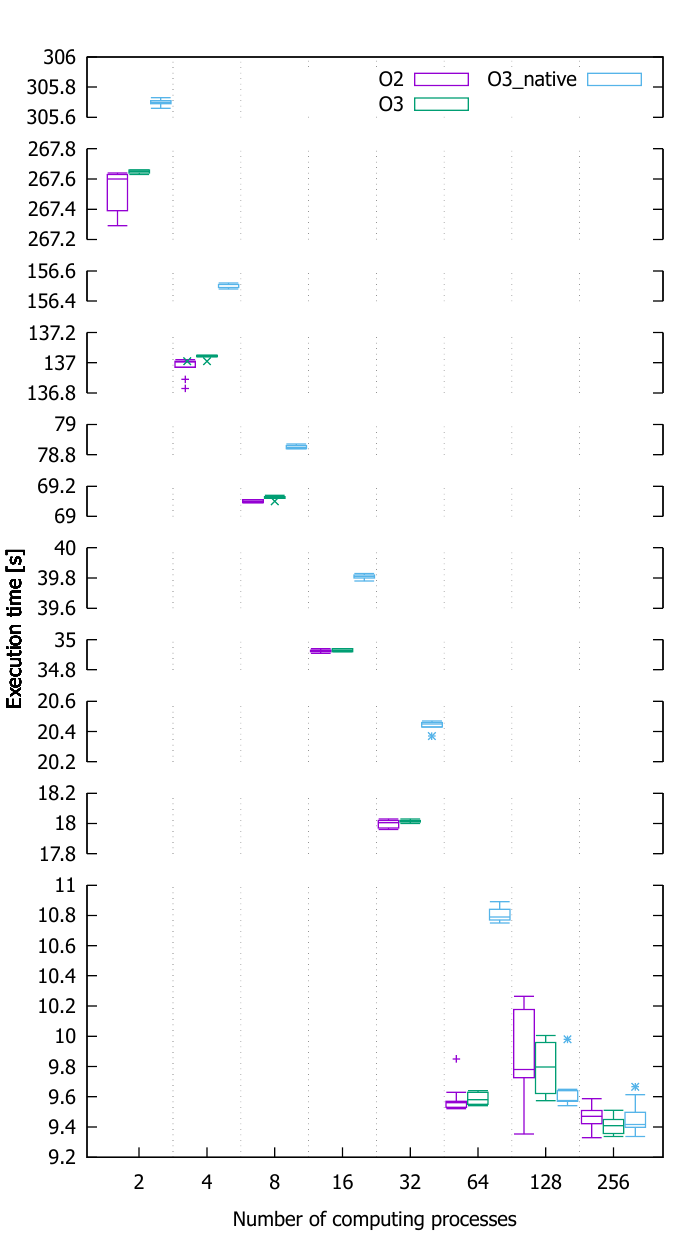
Figure 10. Execution times for DAC, for better of Docker and host versions; boxplot notation: medians, Q1 and Q3, max(Q1 − 1.5IQR, minimum) and min(Q3+1.5IQR, maximum) as well as potential outliers (+ for O2, x for O3, * for